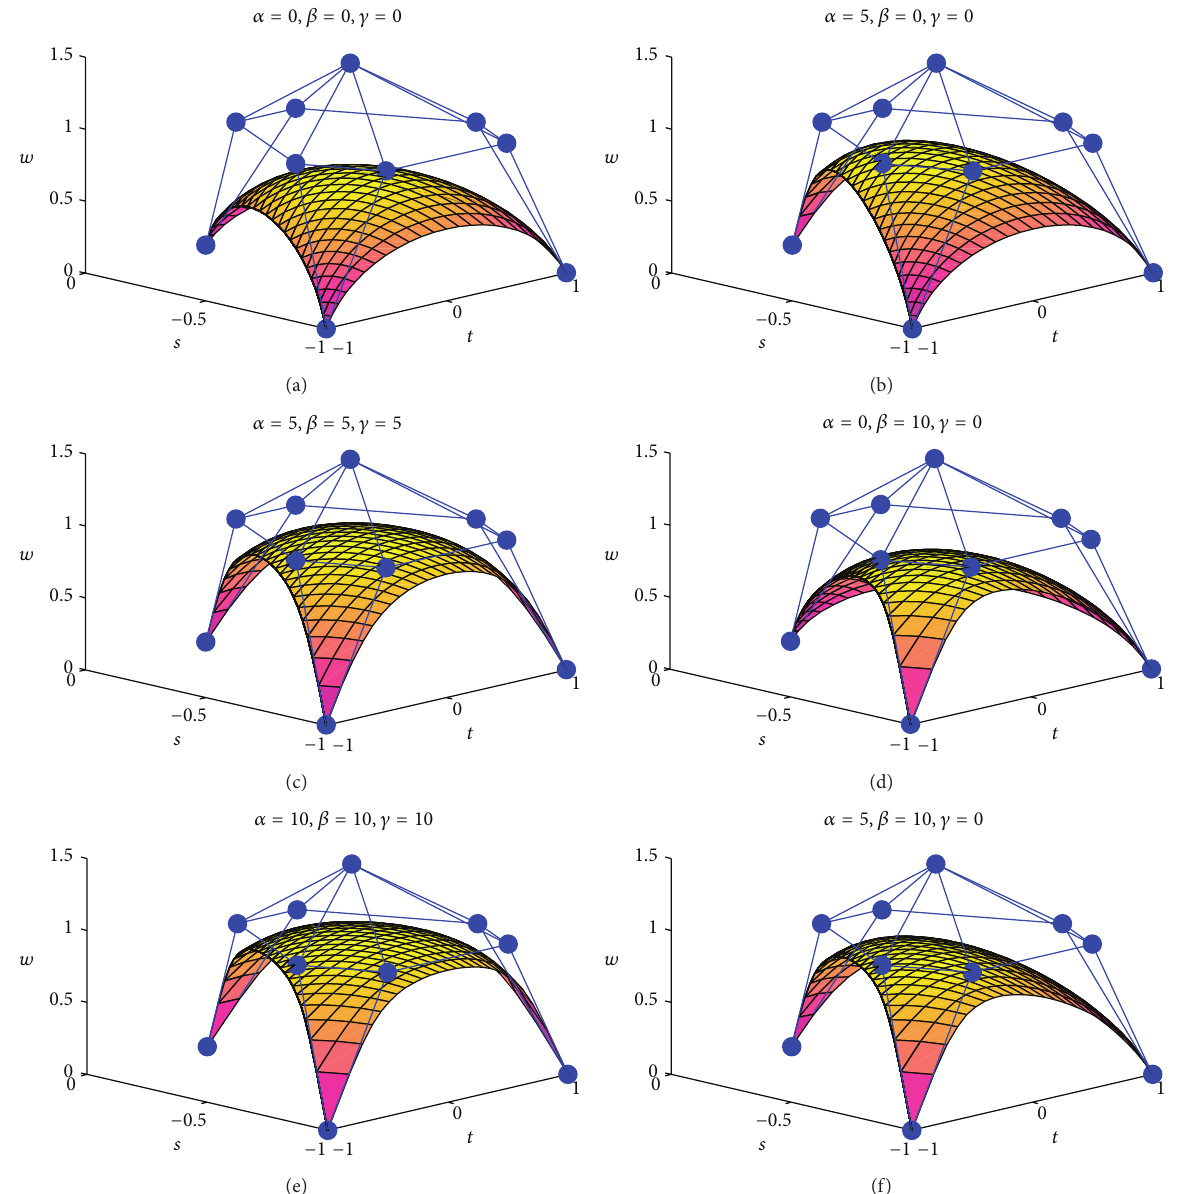
Figure 11: Quartic rational triangular Said-Ball-like patches with different shape